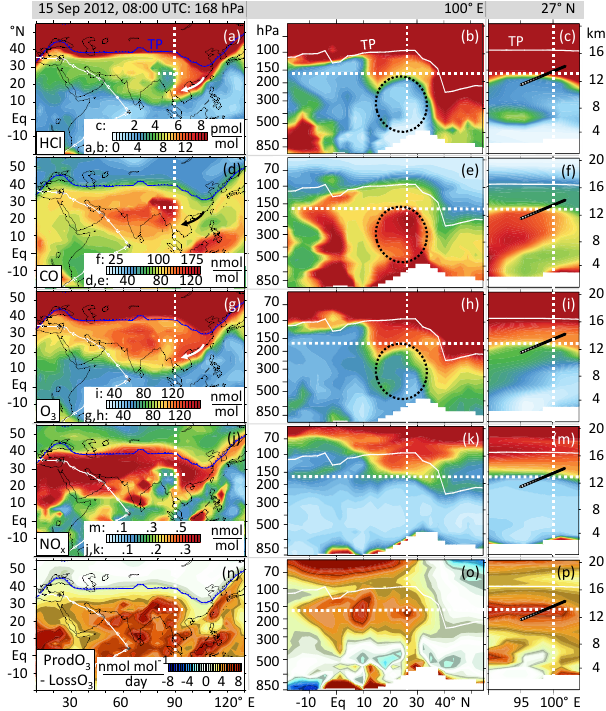
Figure 8. Mixing ratios of HCl, CO, O 3 , NO x , and net photochem- ical O 3 production as simulated by EMAC for 08:00UTC on 15 September 2012. Black bars in the right column indicate the air mass to be encountered by HALO 3 days later. That air mass was passing the eastern flank of the anticyclone at the pictured time. Its eastern part was entrained by uplifted air there, creating a trace gas gradient in the fringe. Zonal and meridional curtains are shown on the right, and positions of the respective two panels are marked by dashed lines in each panel. Arrows and circles indicate features dis- cussed in the